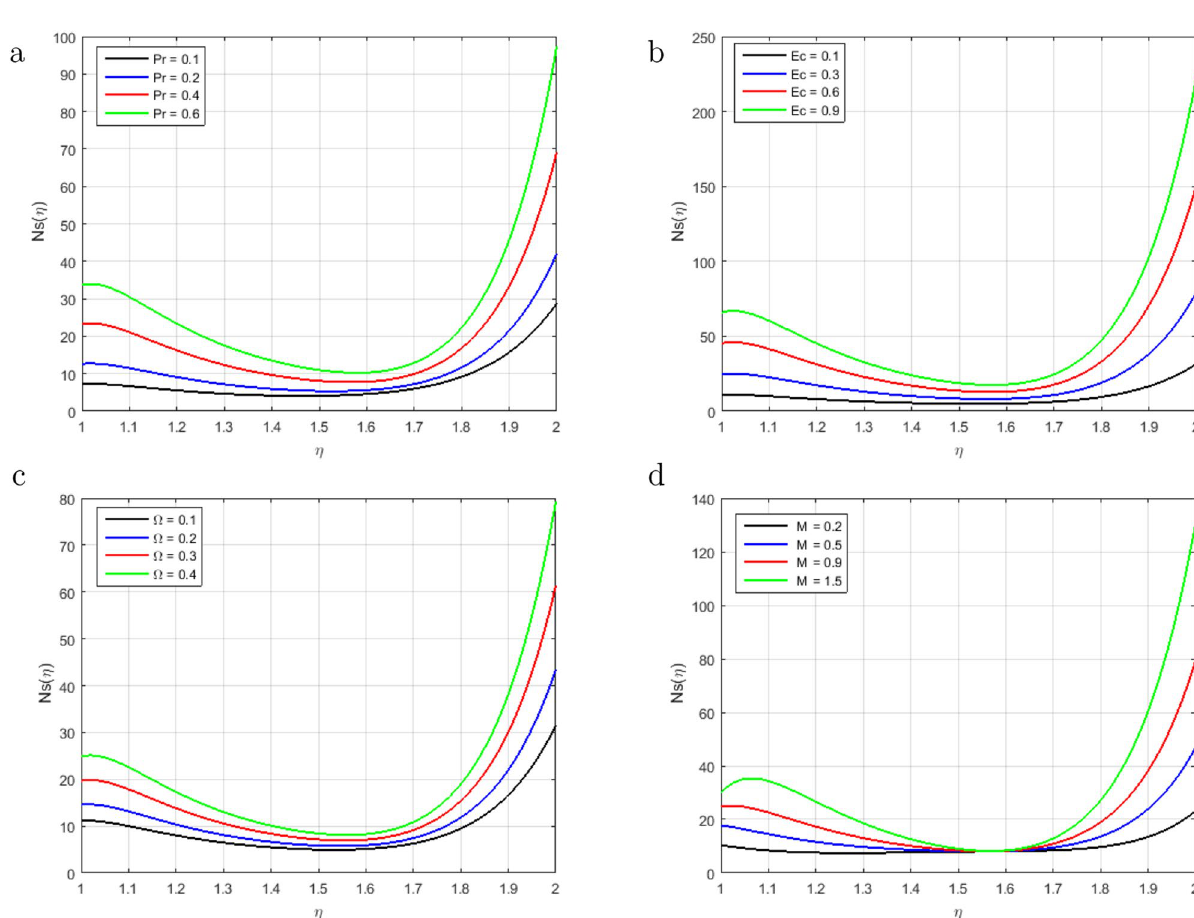
Figure 13. Influence of Ns (η) for Pr , Ec , (cid:31) and M and fixed values of S = 3.3, Re m = 1.7, C 1 = 1.6, Hs = 2.2, Sc = 0.9, Sr = 1.6, δ = 0.5